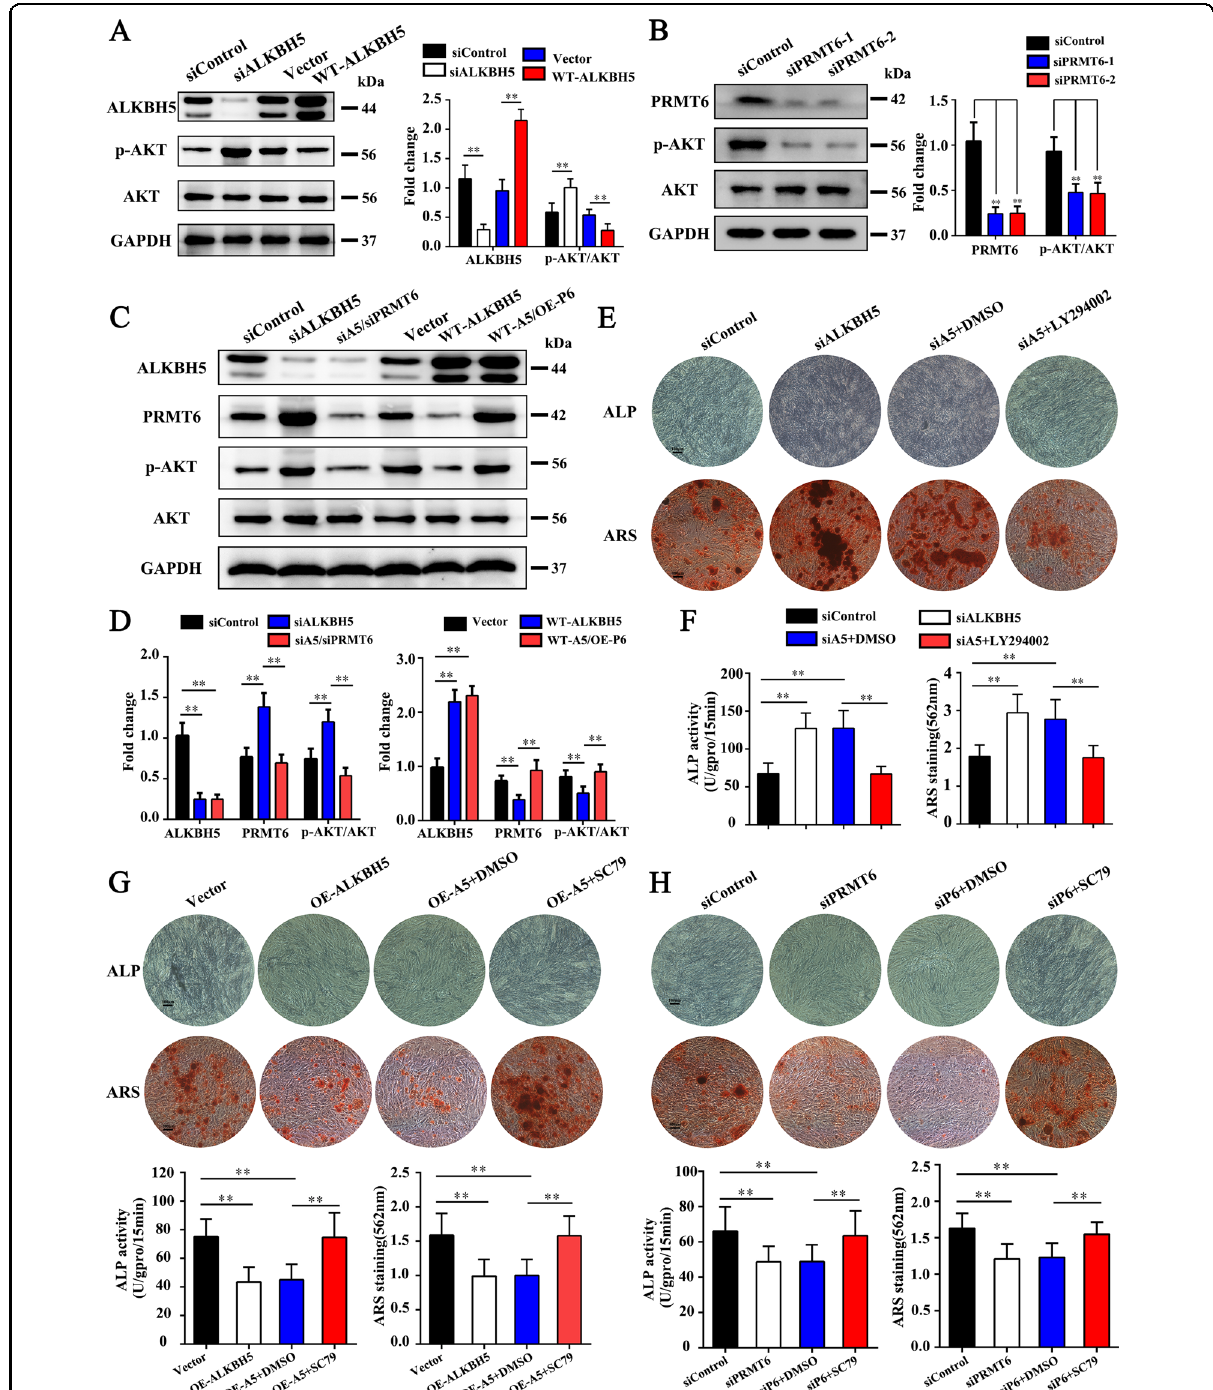
Fig. 7 The ALKBH5-PRMT6 axis controls the activation of the AKT signaling pathway to modulate the osteogenesis of MSCs. A Western blot detection of AKT phosphorylation level after interference with ALKBH5 expression. B Western blot detection of AKT phosphorylation level after knocking down PRMT6 expression. C , D Western blot detection of AKT phosphorylation level after simultaneous knockdown of ALKBH5 and PRMT6, and simultaneous overexpression of ALKBH5 and PRMT6. E , F ALP assay and ARS assay after adding LY294002 (PI3K/AKT pathway inhibitor), while knocking down ALKBH5. Scale bar, 100 µm. G ALP assay and ARS assay after adding SC79 (PI3K/AKT pathway activator), while overexpressing ALKBH5. Scale bar, 100 µm. H ALP assay and ARS assay after adding SC79, while knocking down PRMT6. Scale bar, 100 µm. All data are presented as the means ± SDs. ** p < 0.01 ( n = 3 independent experiments with three different MSC